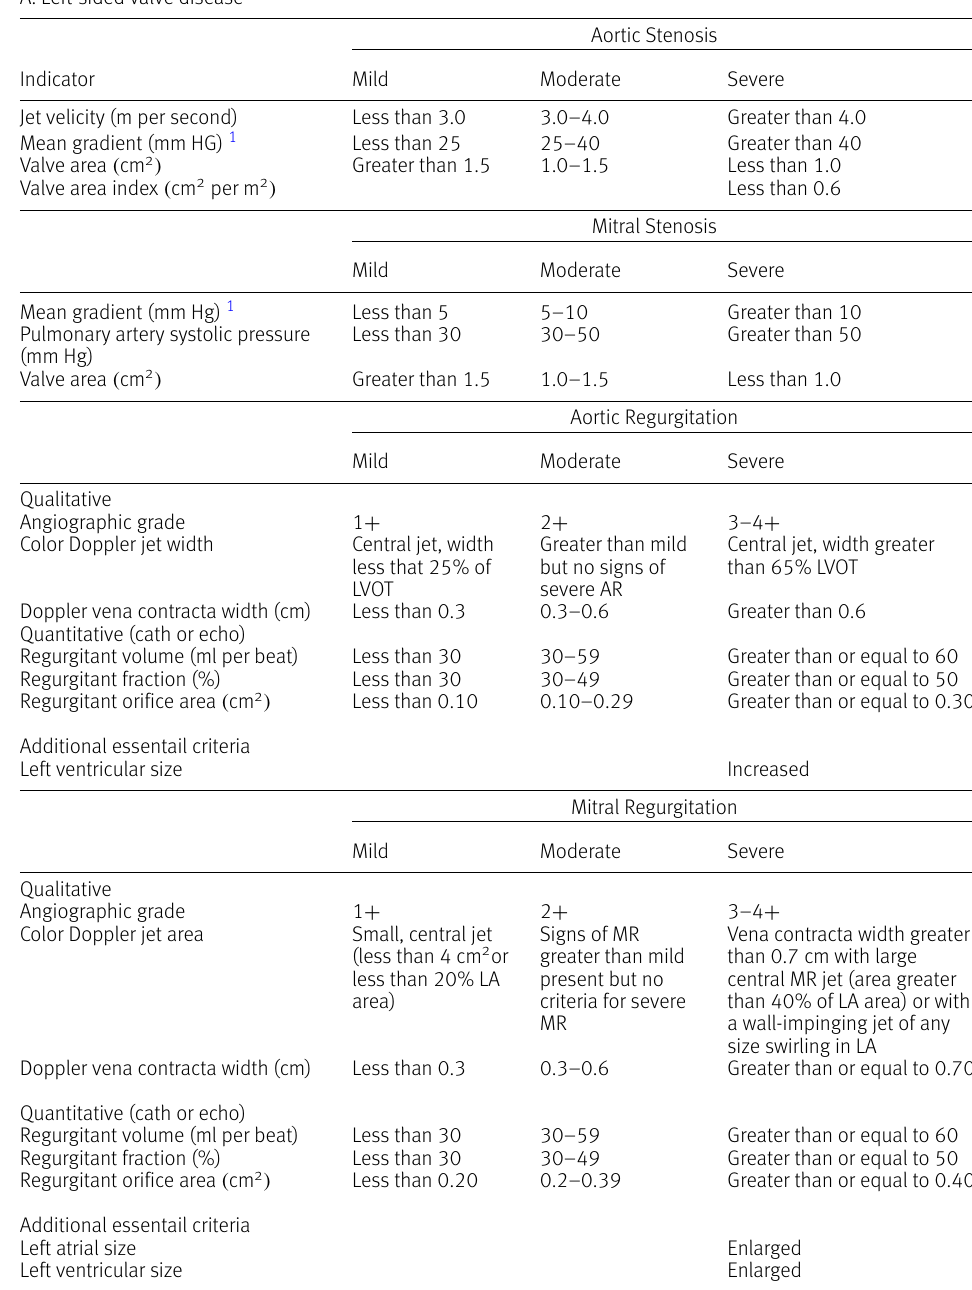
Table 1. Taken from Ref. [1] with